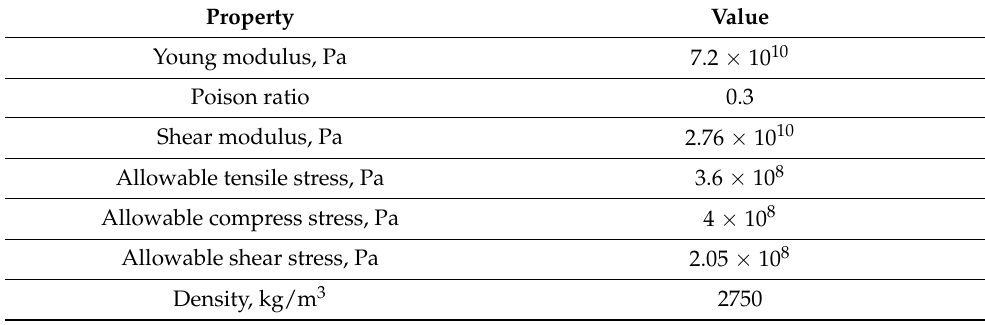
Table 2. Aluminum alloy